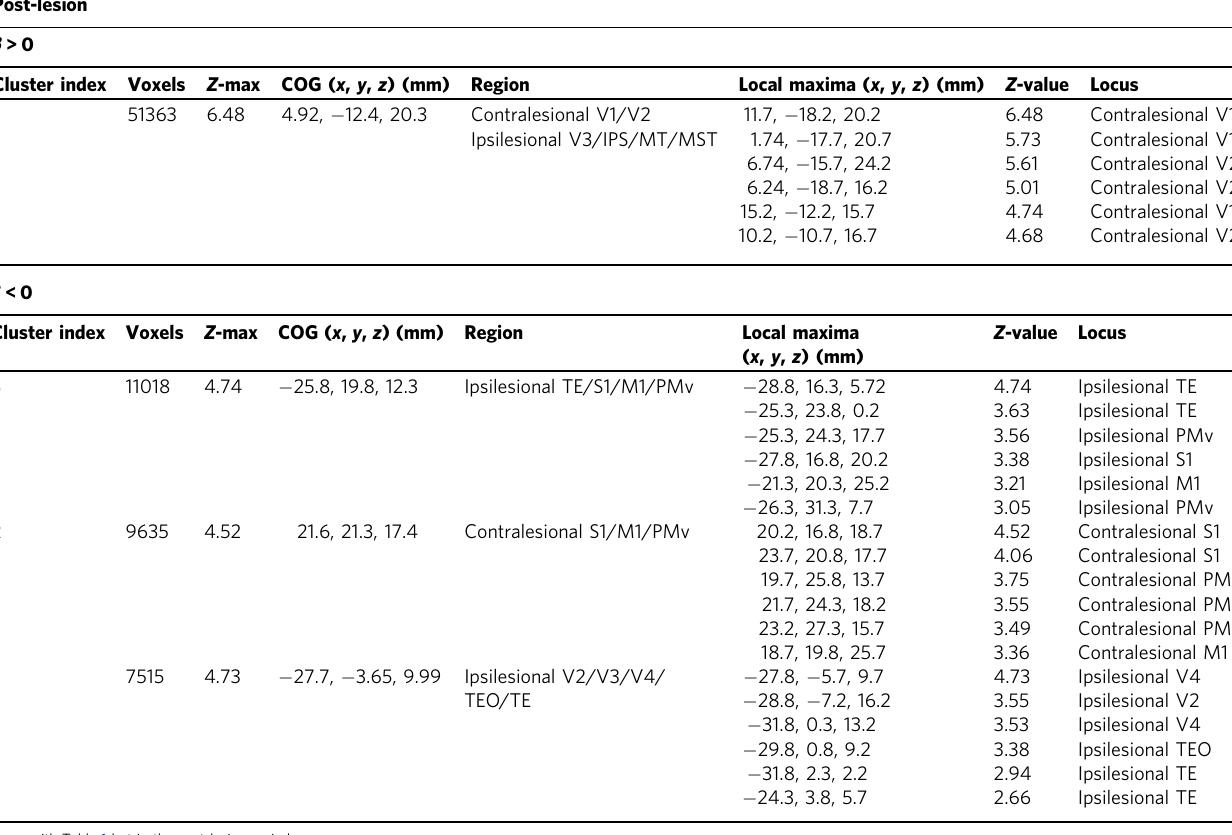
Same with Table 1 but in the post-lesion period. IPS intraparietal sulcus area, M1 primary motor cortex, MST medial superior temporal area, MT middle temporal area, PMv ventral premotor area, S1 primary somatosensory